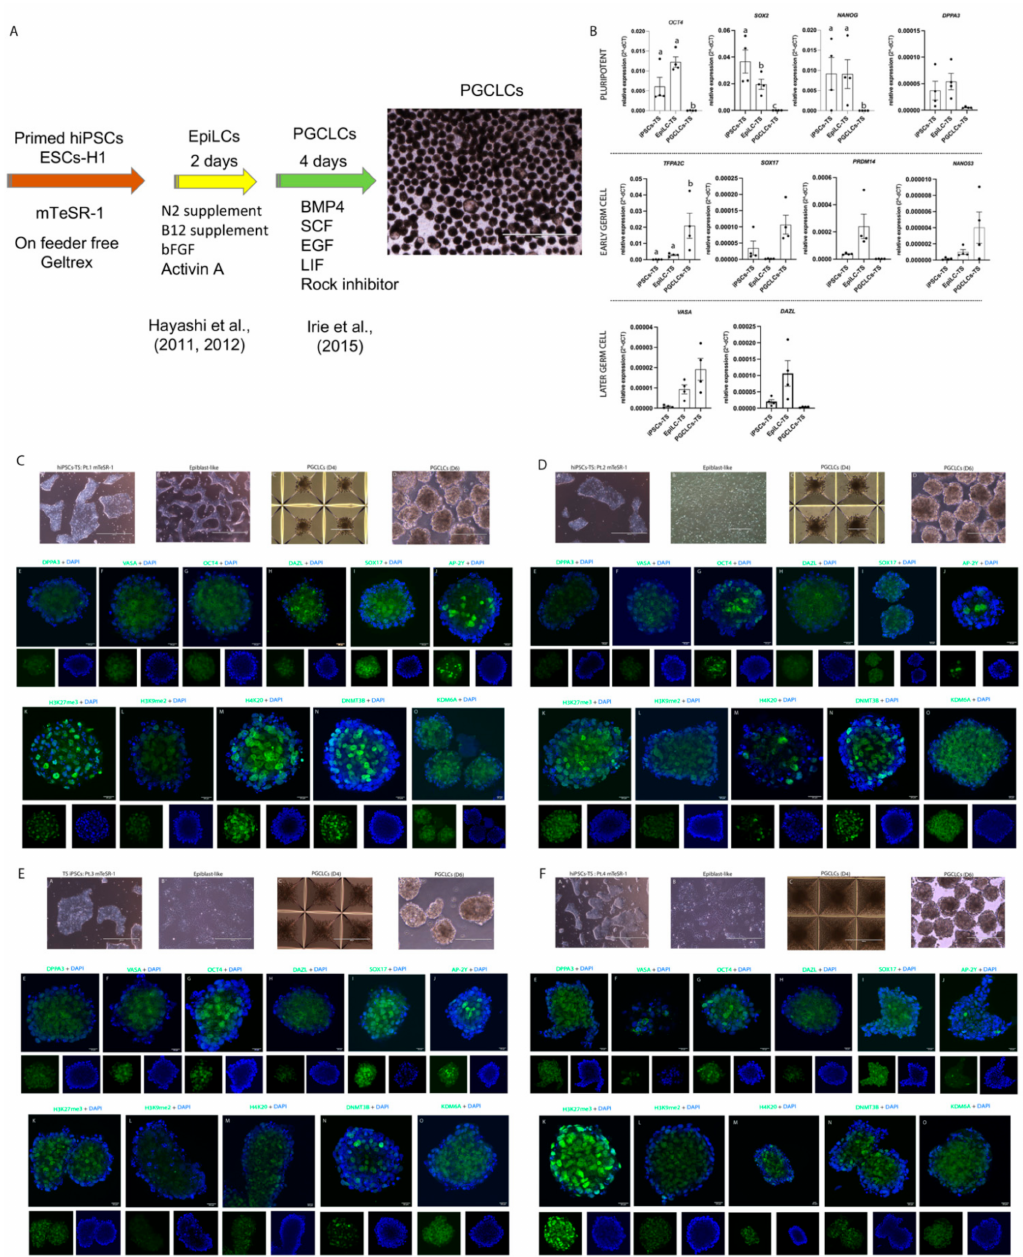
Figure 6. Dynamics of pluripotent and germ cells markers during hPGCLCs -TS induction. ( A ) Schematic protocol used to generate hPGCLCs. ( B ) hiPSCs-TS (p20), hEpiLC-TS (D.2), and hPGCLCs-TS (D.6) quantification of the relative expression of OCT4, SOX2, NANOG, DPPA3, TFAP2C, SOX17, PRDM14, NANOS3, VASA, and DAZL genes associated with germ cells development. Individual reactions of qRT-PCR were normalized to the B-ACTIN gene. The data was compiled from at least four biological replicates and three technical replicates. p values were calculated by Two-way ANOVA, followed by Tukey’s multiple comparisons test as appropriate. (letters a-b-c show difference between groups). Error bars represent SEM. ( C – F ) PGCLCs-TS of Pt.1; PGCLCs-TS of Pt.2; PGCLCs-TS of Pt.3; PGCLCs-TS of Pt.4 showed. Phase contrast image showed hiPSCs-TS maintained in mTeSR-1 medium on Geltrex; hiPSCs-TS(p20) stimulated via hEpiLC; PGCLCs -TS (d4) cultured in Agreewell plates. Scale bars: 200 µ m; hPGCLCs-TS (D.6) isolated for further characterization. Scale bars: 400 µ m. Immunofluorescence analysis showed pluripotency and germ cell markers DDPA3, VASA, OCT4, DAZL, SOX17, and AP-2 γ . Nuclei were stained with Hoechst (blue). Scale bars: 20 µ m. Immunofluorescence analyzed showing the epigenetic profile of histones H3K27me3, H3K9me2, and H4K20; and DNMT3B and KDM6A protein markers. Nuclei were stained with Hoechst (blue). Scale bars: 20 µ m. The data was compiled from at least two technical replicates for all